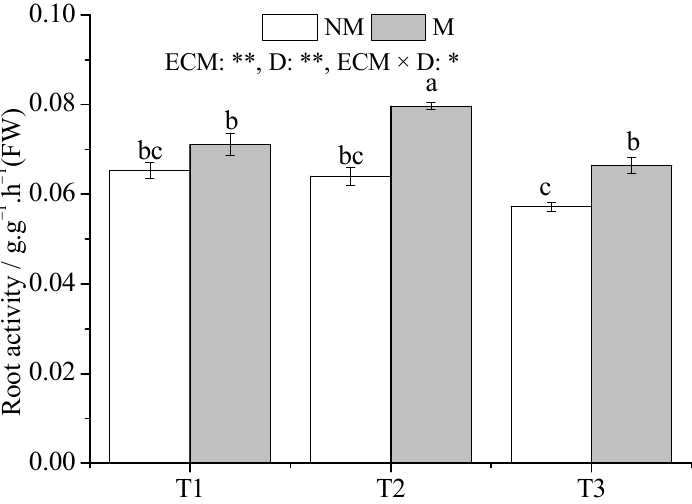
Figure 8. E ff ect of ECMF and drought on root vitality. Values (means ± SEs) followed by di ff erent Figure 8. Effect of ECMF and drought on root vitality. Values (means ± SEs) followed by different le tt ers among treatments indicate signi fi cant di ff erences at the 5% level, and the same le tt er indicates letters among treatments indicate significant differences at the 5% level, and the same letter indicates no significant difference. NS, not significant, * p < 0.05; ** p < 0.01. T1, well-watered, T2, moderate drought, and T3, severe drought. NM, no Sl inoculation, M, Sl inoculation. D, drought